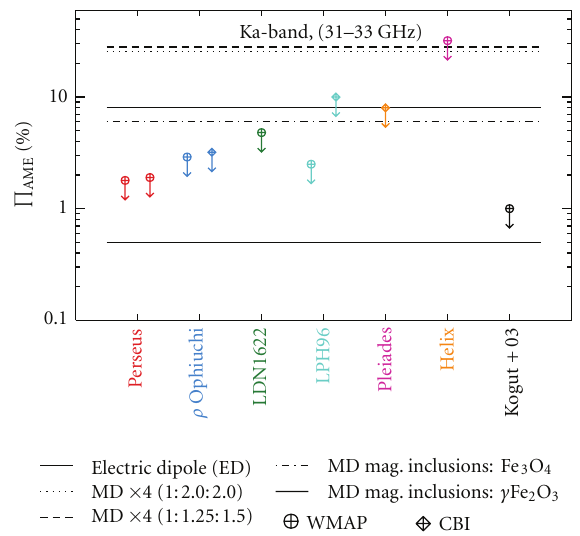
Figure 6: Observational constraints on the polarisation fraction of the AME at 23GHz for individual regions and on all sky (see Table 1). The horizontal lines correspond to di ff erent theoretical predictions in this frequency band, both for electric dipole emission (ED) and magnetic dipole emission (MD) models. The solid line shows the expected polarisation fraction for the Cold Neutral Medium (spinning dust) model proposed by [34]. The dotted and dashed lines correspond to the polarisation fraction for MD from perfectly aligned grains consisting of a single magnetic domain [37]. The polarisation fraction from randomly oriented magnetic inclusions [42] is shown by the dot-dashed and dot-dot-dashed lines.